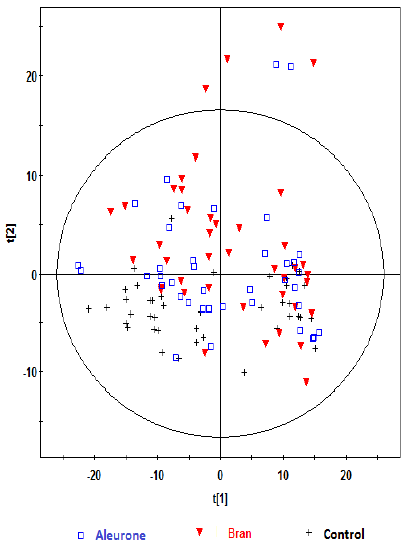
Figure 1. Principal component analysis (PCA) scores plot t[1] vs. t[2] obtained from 1 H NMR spectra of urine samples of fourteen participants at baseline and at one and two hours after consumption of aleurone, bran or control treatments, showing the different treatments. Observations ( n ) = 122. The ellipse represents 95% confidence region of the model based on Hotelling T 2 .